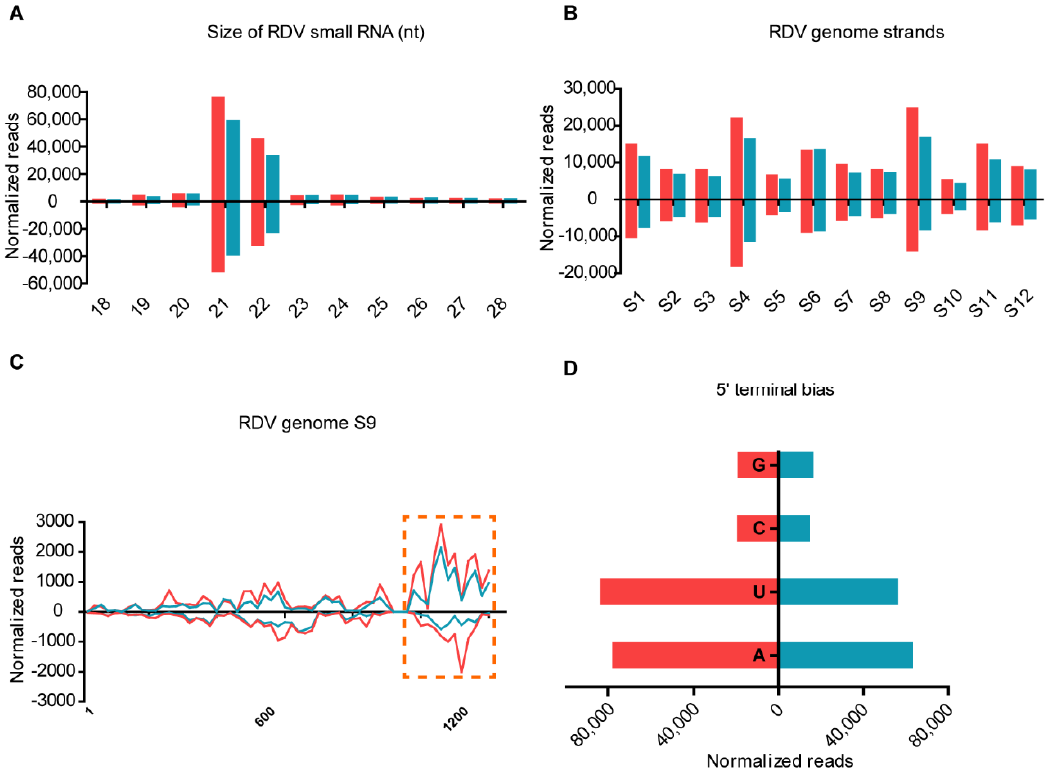
Figure 4. Comparison of vsiRNAs in response to RDV infection between OsRDR6AS and wild type (WT) plants. ( A ) Size distribution of RDV vsiRNAs. Normalized reads of 18- to 28-nt RDV vsiRNAs are shown. ( B ) Abundance of RDV vsiRNAs mapped to each of the 12 RDV genomic RNAs. ( C ) Location of vsiRNAs from the two libraries in RDV genomic RNA S9. ( D ) 5 ′ -terminal first nucleotide bias in the two libraries. Red bars or lines indicate WT; blue bars or lines indicate OsRDR6AS.